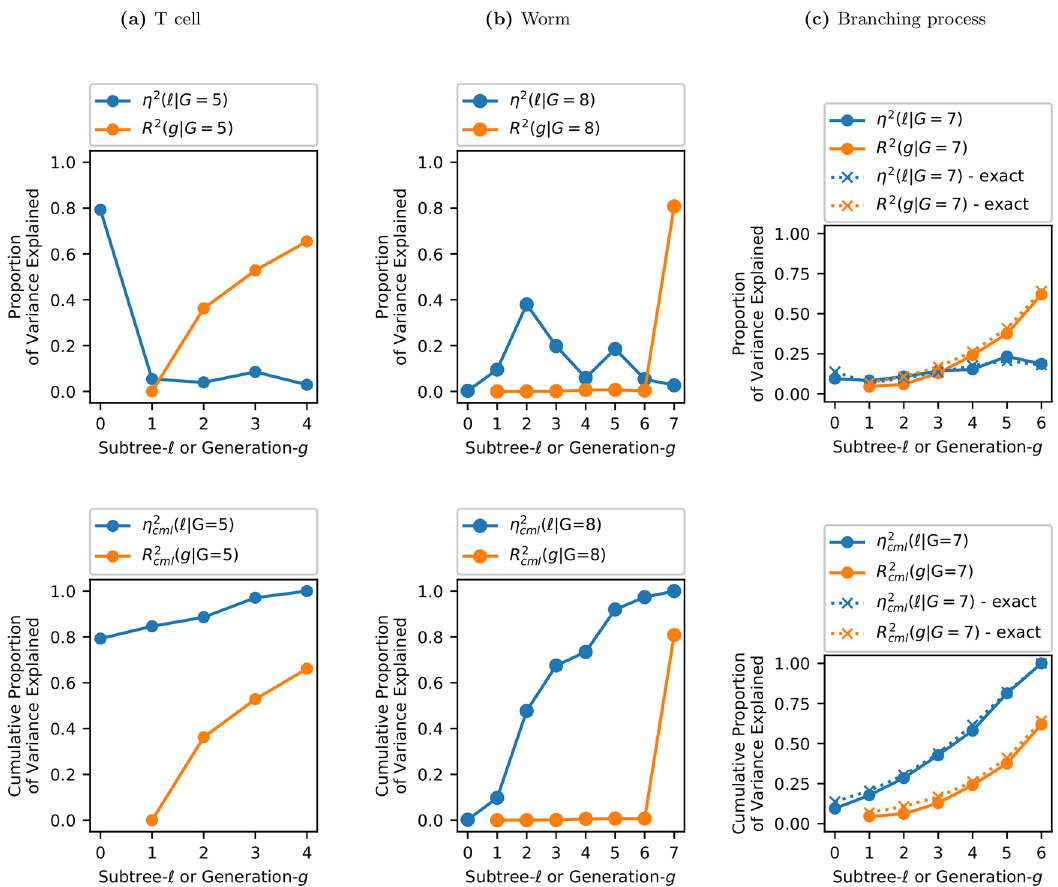
Fig 11. Fate profiles for different lineages. Explained variance (top row) and the cumulative explained variance (bottom row). η 2 ( ℓ | G ) (blue) measures how much the fate of a cell at generation G is restricted by each subtree ℓ . R 2 ( g | G ) (orange) measures how much a generation- G cell’s phenotype is correlated with its direct ancestor in generation g . Note that because the Markov process is assumed to be first order (see Section ‘Sparsity.’), R 2 ¼ R 2 . For the case of the simulated branching process the exact result is also cml shown. This illustrates the accuracy of the inference